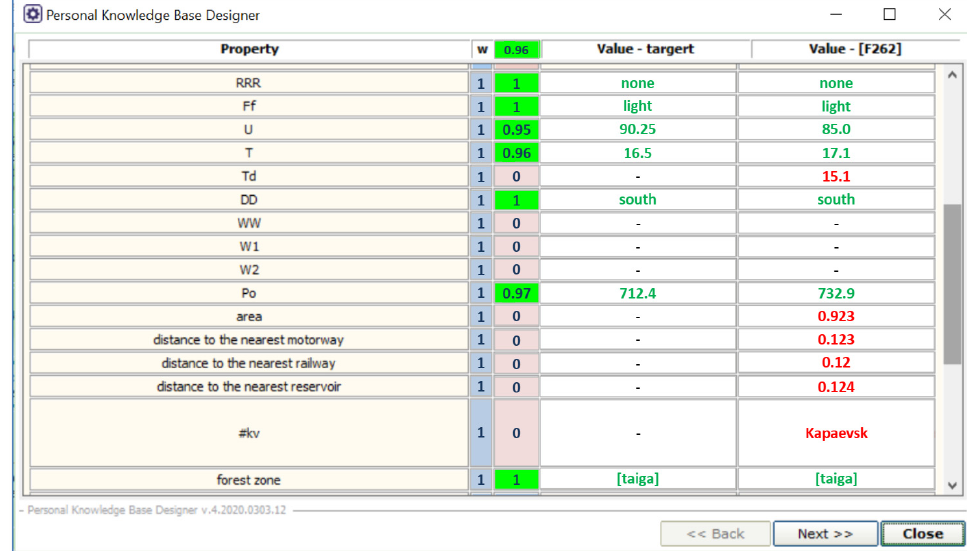
Figure 9. An example of a PKBD GUI form: detailed preview of the CBR results. (RRR, the amount of precipitation; Ff, wind strength; U, relative humidity of the air; T, air temperature; Td, dew point temperature; DD, wind direction (rumba); WW, current weather reported from the weather station; W1, past weather between observation dates 1; W2, past weather between observation dates 2; Po, atmospheric pressure). To highlight the importance of values, a color indication is used: when comparing properties, close values are displayed in green, non-close values are displayed in red; when showing similarity, a high similarity is displayed on a green background, a pale pink back- ground is used for a low one, and yellow and blue colors are also possible for intermediate values of similarity.